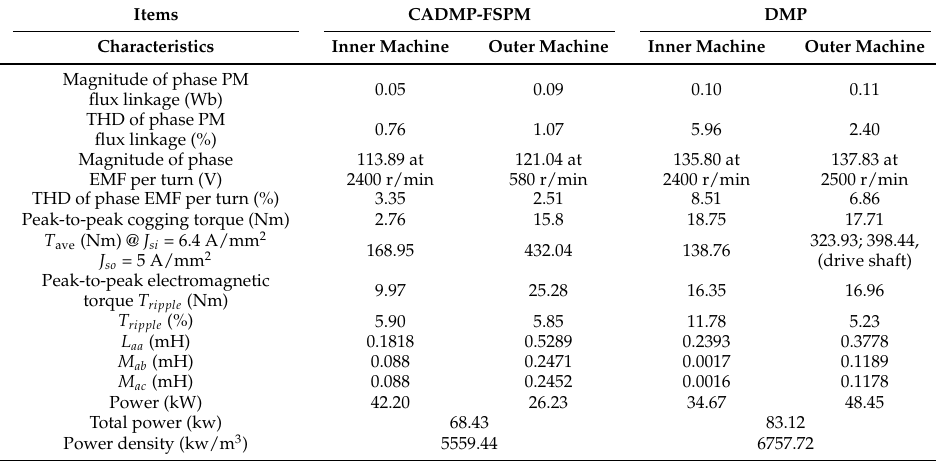
Table 4. Comparison of the characteristics of the CADMP-FSPM machine and the DMP machine. THD, total harmonic